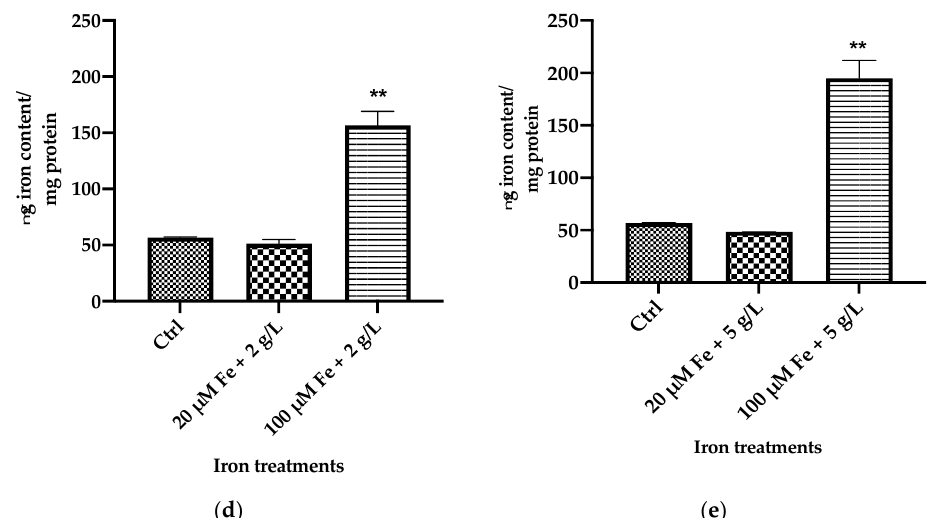
Figure 1. Effect of transferrin treatments alone or in combination with iron on MIN6 cell intracellular iron content. Data are presented as follows: ( a ) Dose-response effects of a range of transferrin concentrations (0.005 g/L, 0.05 g/L, 0.5 g/L and 5 g/L) loaded into MIN6 cells for 24 h. The data represent mean ± SEM, n = 3. * p < 0.018. (0.005. g/L vs. 0.5 g/L), * p < 0.033 (0.005 g/L vs. 5 g/L). ( b) Effects of 0.05 g/L transferrin loaded into MIN6 cells in combination with 20 μM or 100 μM for 24 h. ( c ) Effects of 0.5 g/L transferrin loaded into MIN6 cells in combination with 20 μM or 100 μM for 24 h. ( d )Effects of 2 g/L transferrin loaded into MIN6 cells in combination with 20 μM or 100 μM for 24 h. ( e ) Effects of 5 g/L transferrin loaded into MIN6 cells in combination with 20 μM or 100 μM for 24 h. The data (b–e) represent mean ± SEM, n = 3. Significances are as follows; * p < 0.048 (0.05 g/L), * p < 0.0138 (0.5 g/L), ** p < 0.0036 (2 g/L), ** p < 0.0031 (5 g/L).